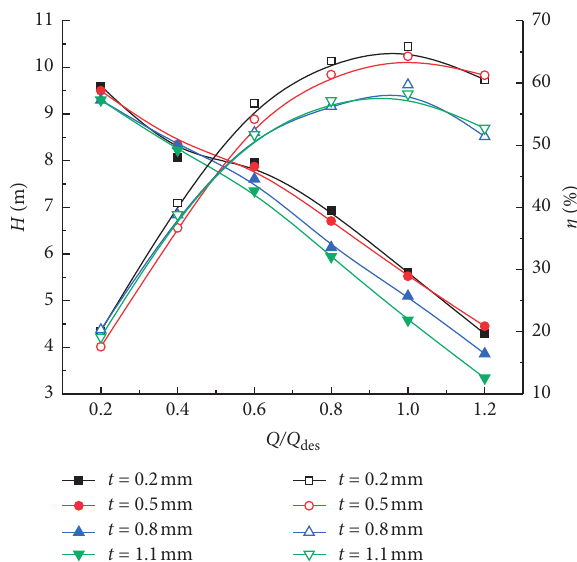
Figure 5: Comparison of energy performance curves with different tip